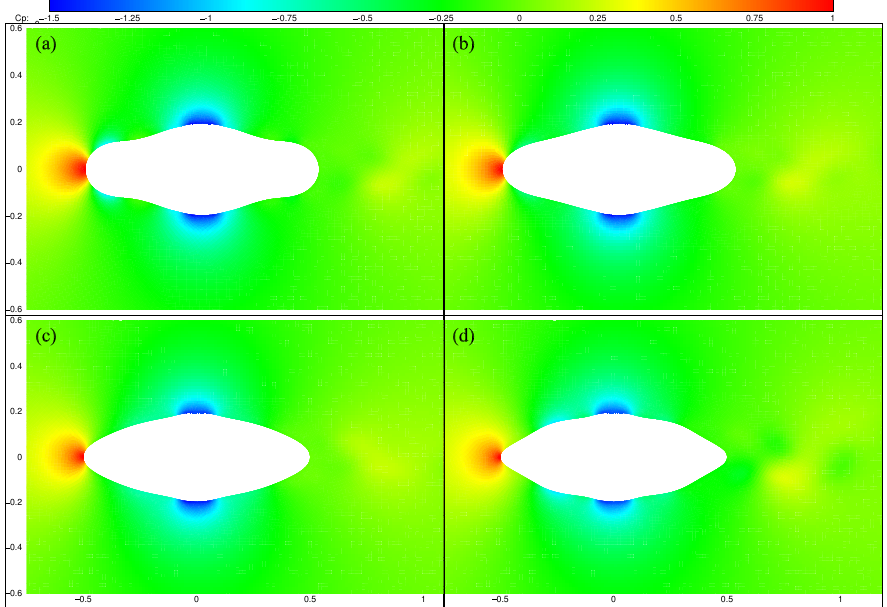
Figure 7. The contour of pressure coefficient around AUH model for different simulation cases of θ D = 13 ◦ : ( a ) θ C = 5 ◦ ; ( b ) θ C = 13 ◦ ; ( c ) θ C = 21 ◦ ; ( d ) θ C = 29 ◦ . (Both x and y coordinate is nodimensionalized with AUH’s diameter D